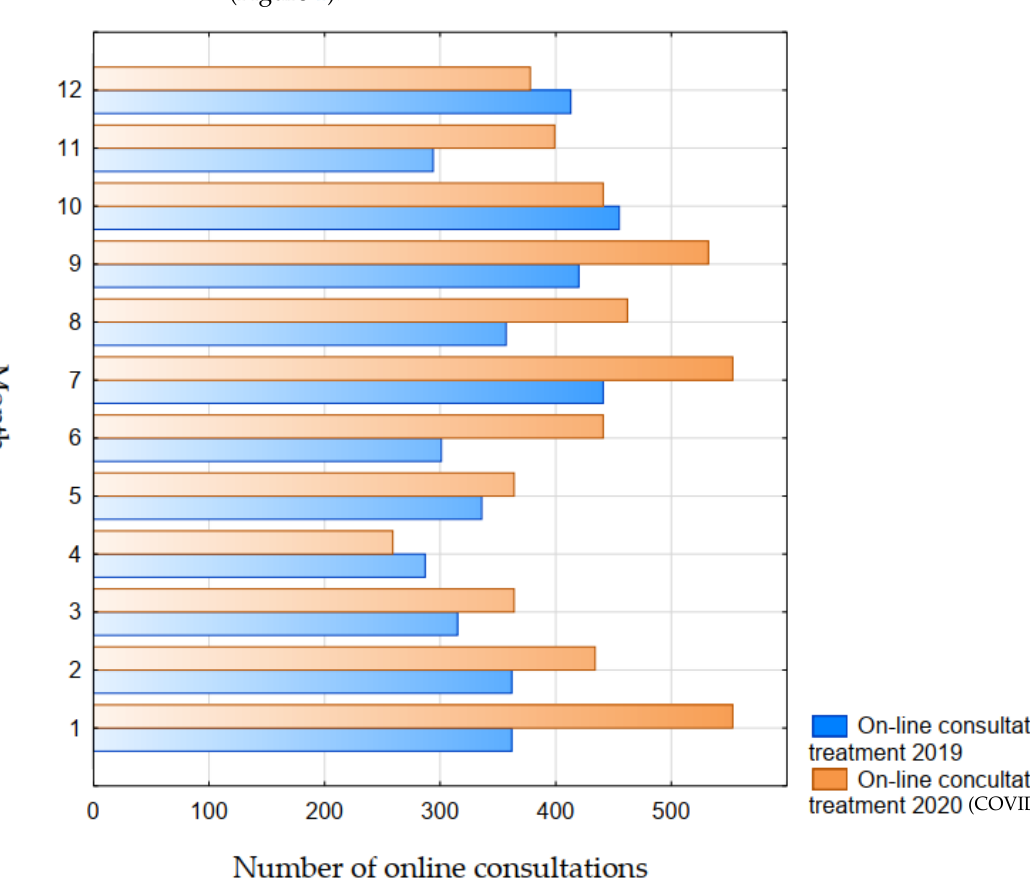
Figure 1. Change in the number of online consultations during lockdown compared to the pre-pandemic period.